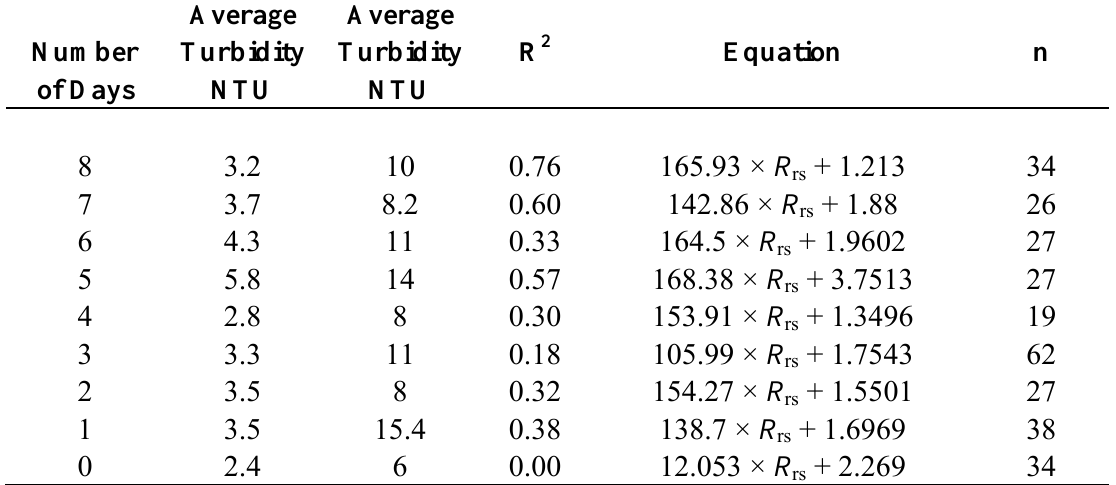
Table 2. Relationships between in situ turbidity (NTU) and R by the number of days after rainfall event. All relationships were significant (P < 0.01).